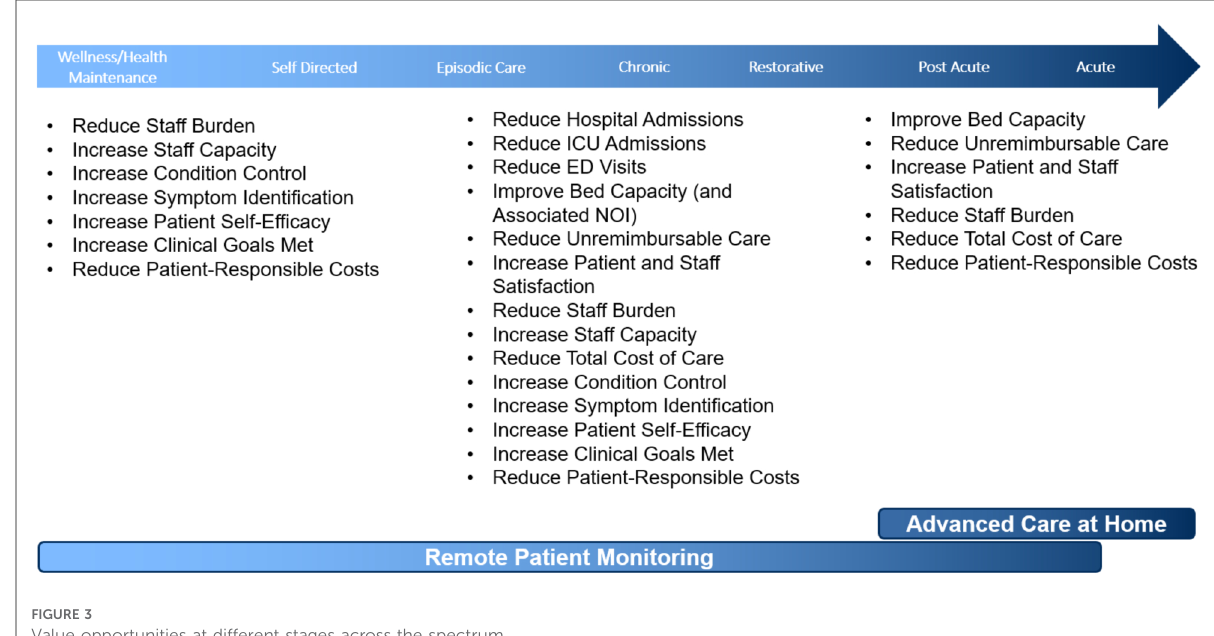
FIGURE 3 Value opportunities at different stages across the